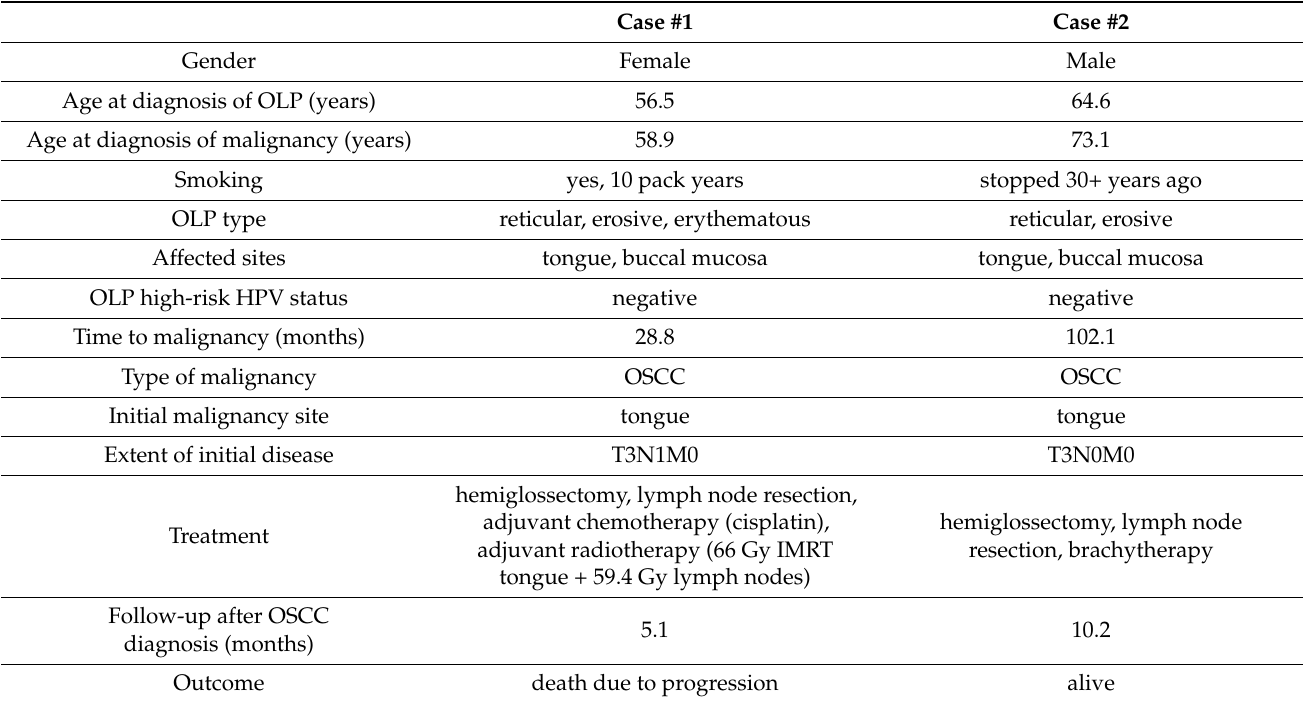
Table 3. Description of the cases with malignant